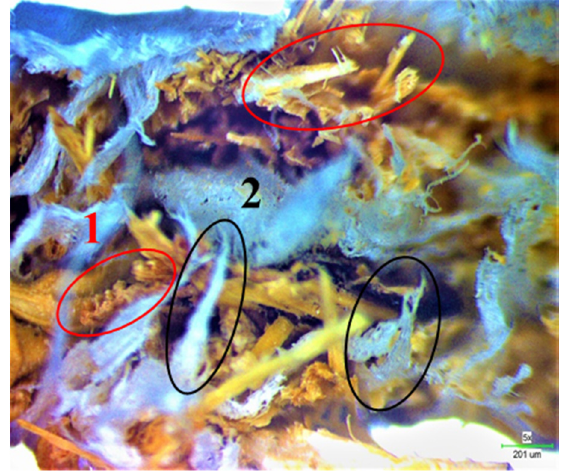
Figure 7. Optical micrograph of fracture surface of the hot pressed straw/LLDPE composite.